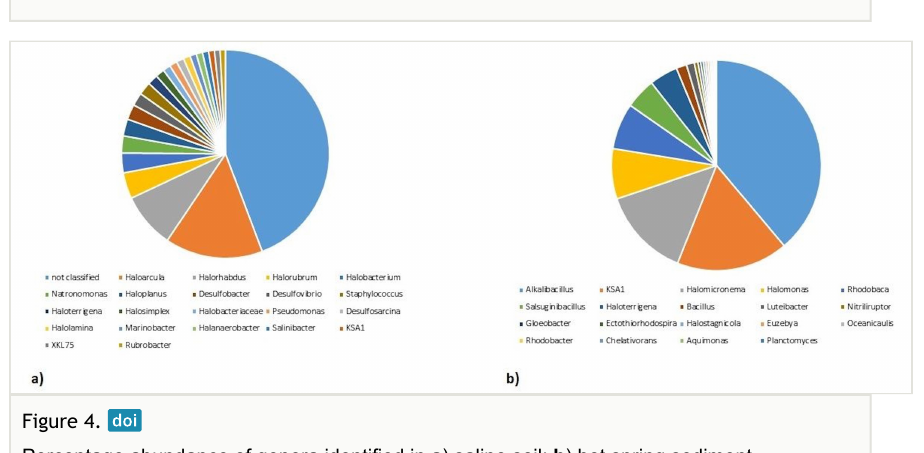
Percentage abundance of families identified in a ) saline soil; b ) hot spring sediment.